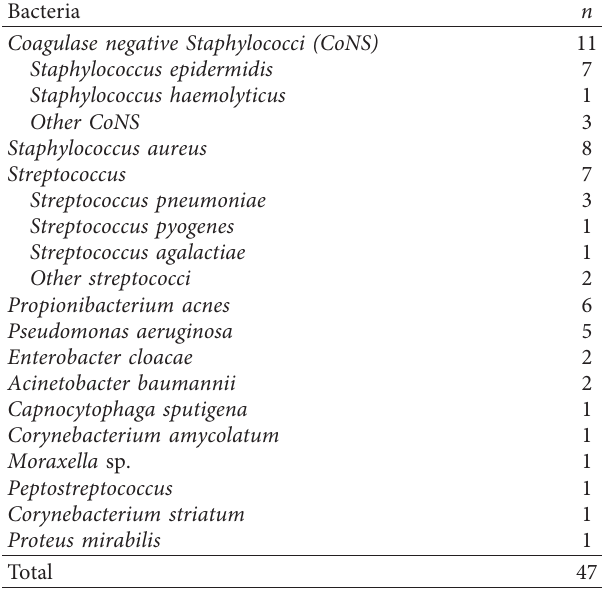
Table 4: Bacteria isolated from cases of infectious keratitis in patients who underwent enucleation or evisceration due to in- fectious keratitis between January 2007 and December 2018 at the Department of Ophthalmology of Semmelweis University (Budapest, Hungary) (48 eyes of 47